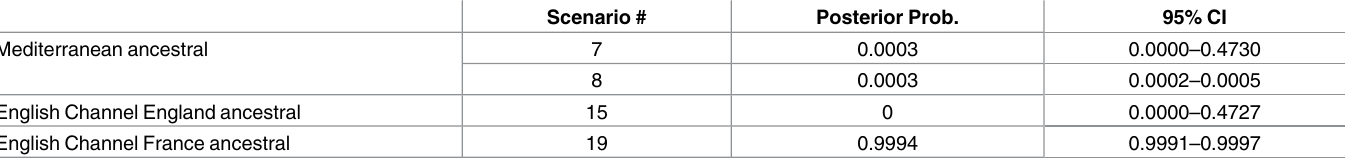
Table 8. Posterior probabilities and 95% confidence intervals (CI) for the most likely Clade E dispersal scenarios, when the best scenarios from each ancestral set are compared against each other.